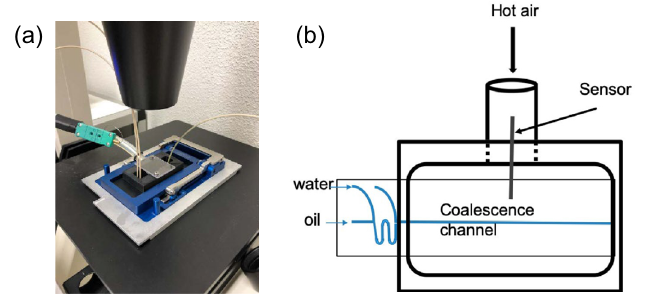
Figure 2. A Lab-ona-chip where temperature can be increased while performing coalescence experiments; ( a ) the actual temperature unit attached to the coalescence chamber at top, ( b ) a schematic explaining the use of heated air to elevate the temperature of the